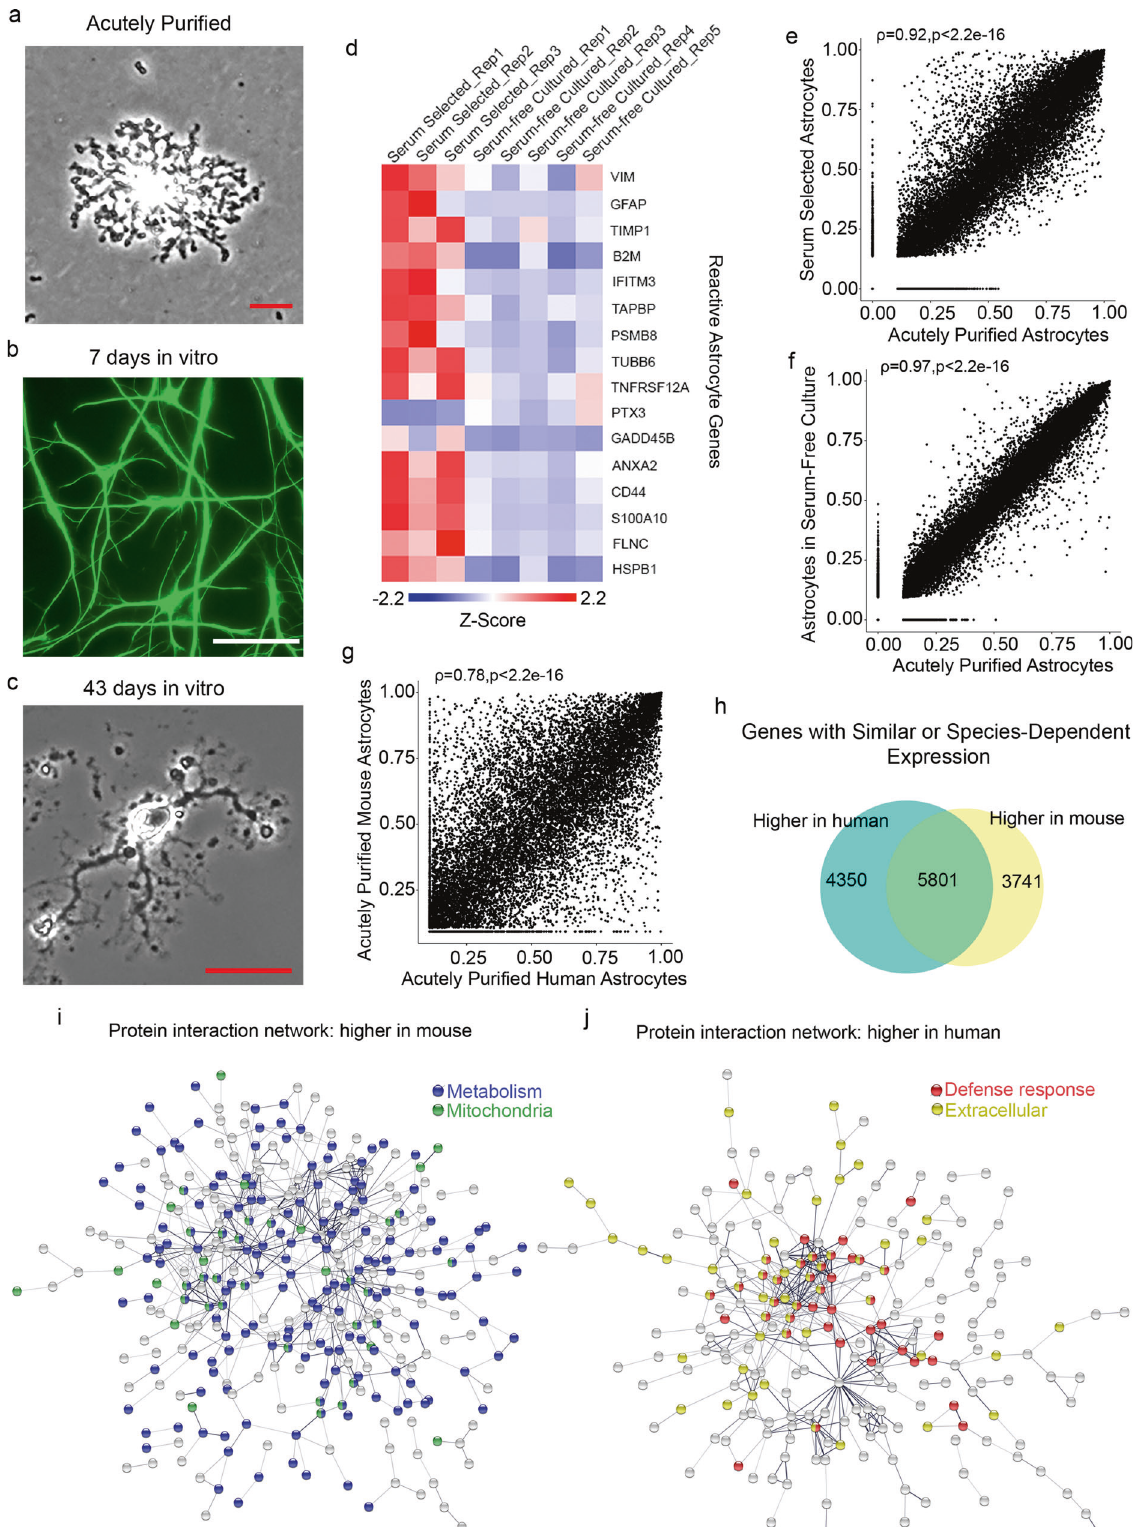
puri fi ed primary human fetal astrocytes, and then injected them into the brains of neonatal mice (Fig. 2a). We aged the xeno- grafted chimera mice for about 8 months, and then con fi rmed widespread distribution of human astrocytes in the host mouse brains (Fig. 2b – e). We then puri fi ed all astrocytes (human and mouse) from the chimeric mice by immunopanning